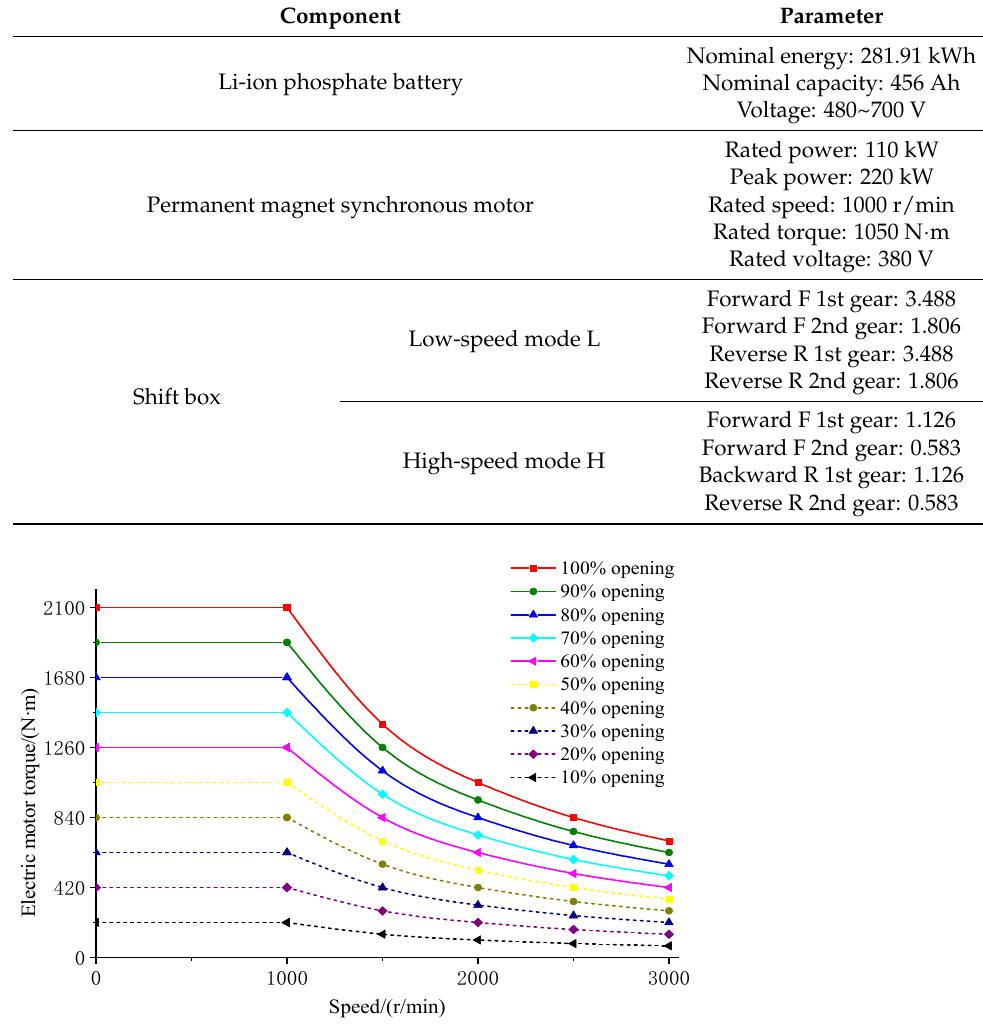
Table 1. Parameters of the power battery, electric motor model, and mechanical transmission model.